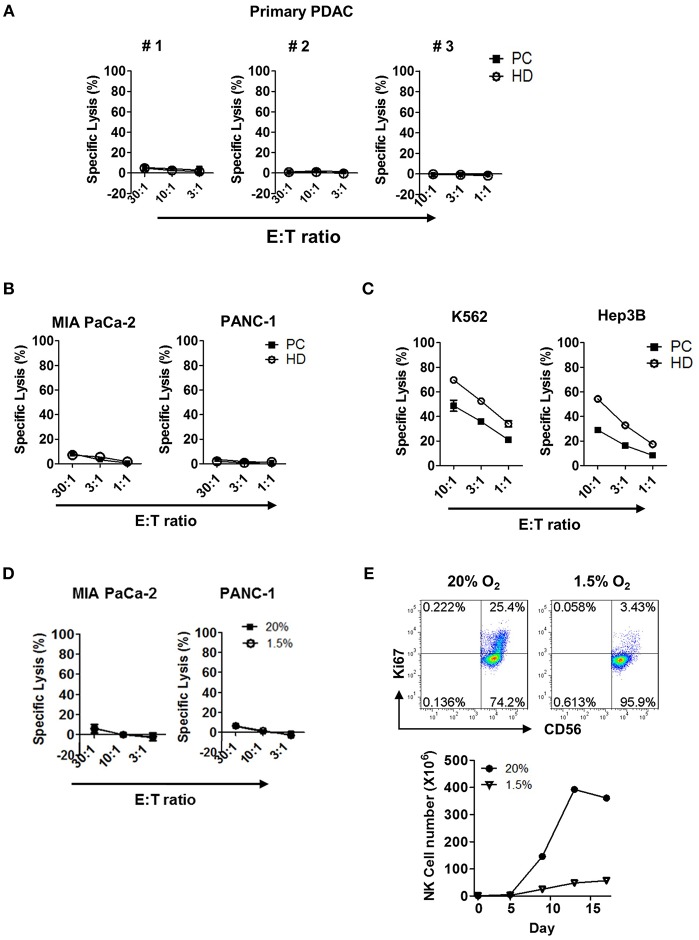
Cytotoxicity and proliferation characteristics of resting NK cells against PDAC tumor cells in both normoxic and hypoxic conditions. Cytotoxicity results of resting NK cells from patients (■) and healthy donors (°) against (A) primary PDAC cells, (B) MIA PaCa-2 and PANC-1, and (C) K562 and Hep3B cells are shown. Results were obtained from three different donors at indicated E:T ratios. (D) The cytotoxicity assays of resting NK cells from patients with PDAC against MIA Paca-2 and PANC-1 were performed under 20 and 1.5% O2 conditions. (E) NK cells isolated from healthy donors were cultured with IL-2 for 96 h, under normoxic or hypoxic conditions, were stained with Ki-67 and analyzed by flow cytometry. Data shown here are representative of five independent experiments.